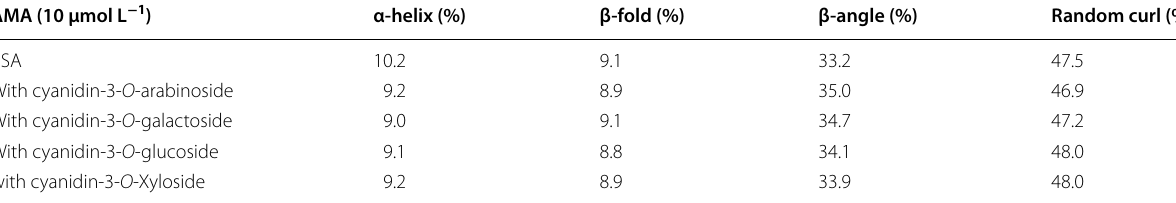
Table 3 Secondary structure analysis from the BSA and AMA AMA (10 μmol L − 1